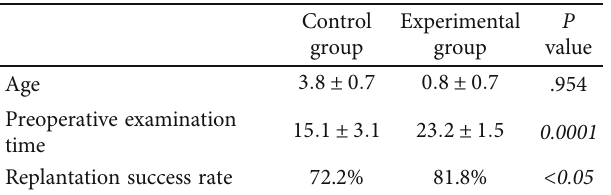
Figure 1: Special insulation box for an amputated limb. Table 1: The preoperative examination time and replantation success rate in the control group and experimental